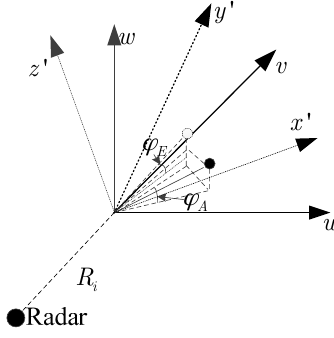
Figure 2. The three-dimensional imaging model of rotating target.